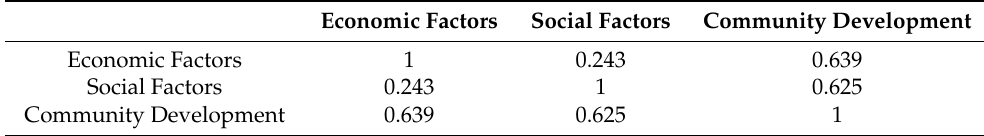
Table 9. Latent variable correlation